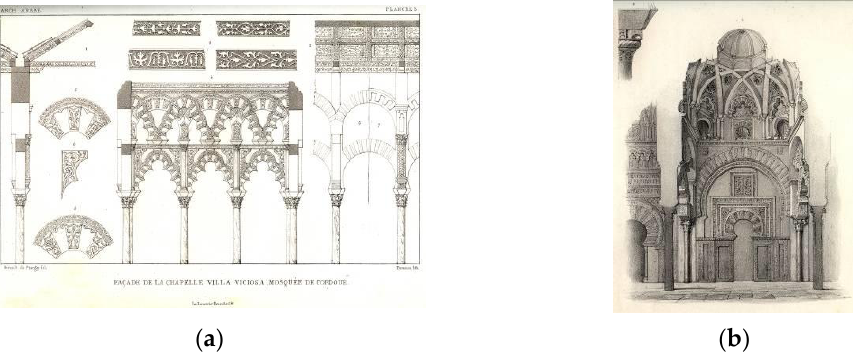
Figure 10. Girault de Prangey: ( a ) Villaviciosa Chapel facade (Bouillon, lit.); ( b ) Section-perspective from the surrounding mihrab (Chapuy, dib.; Asselineau, lit.). Source: Essai sur l’architecture des Arabes et des Mores, en Espagne... 1841.